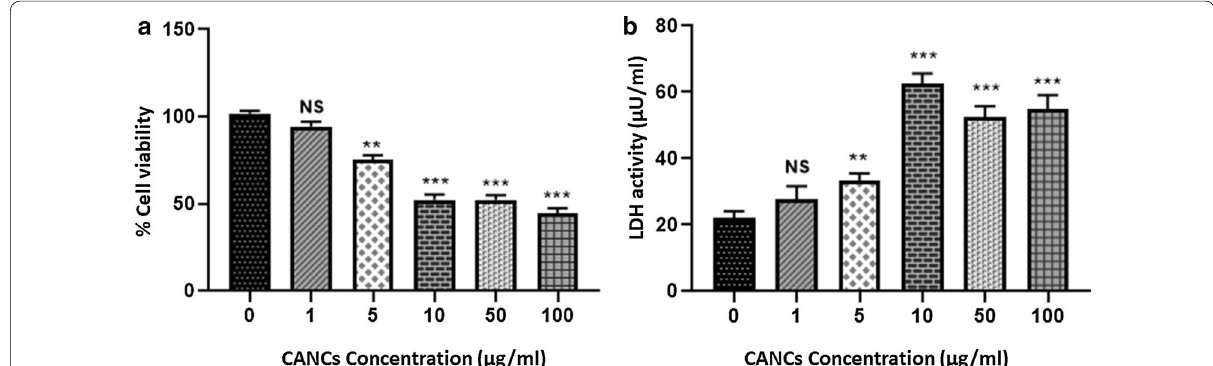
Fig. 7 Anticancer activity of CANCs: a Effect of CANCs on cell viability of MCF-7 cells treated with various concentrations of CANCs. b Shows LDH based cytotoxicity assay in MCF-7